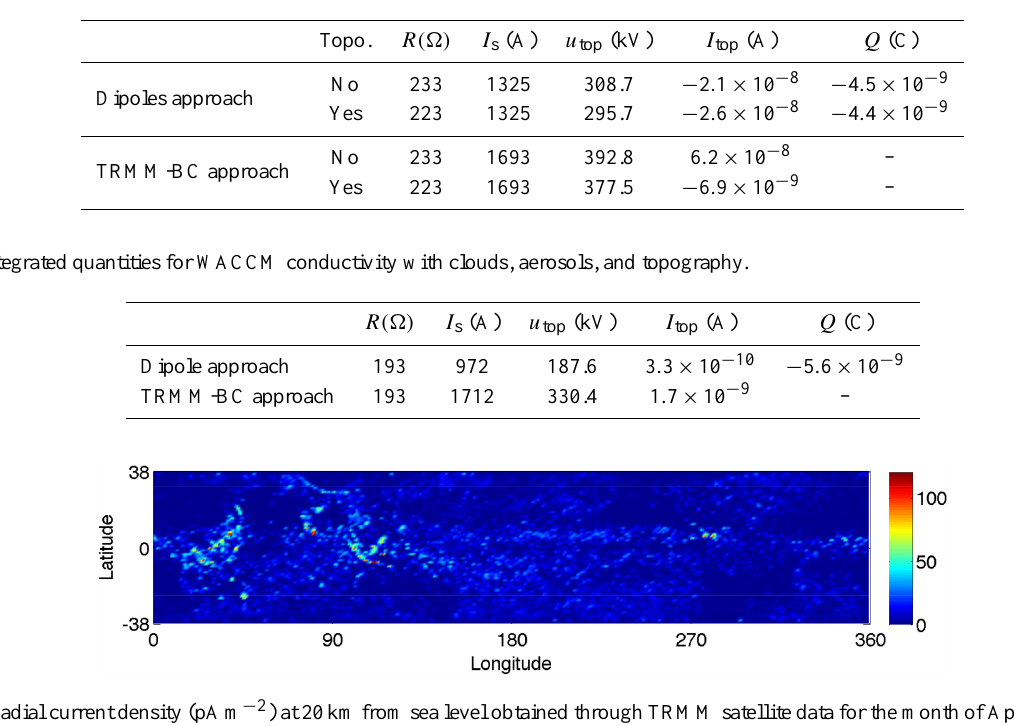
Figure 5. Radial current density (pAm − 2 ) at 20km from sea level obtained through TRMM satellite data for the month of April at 12:00UT.